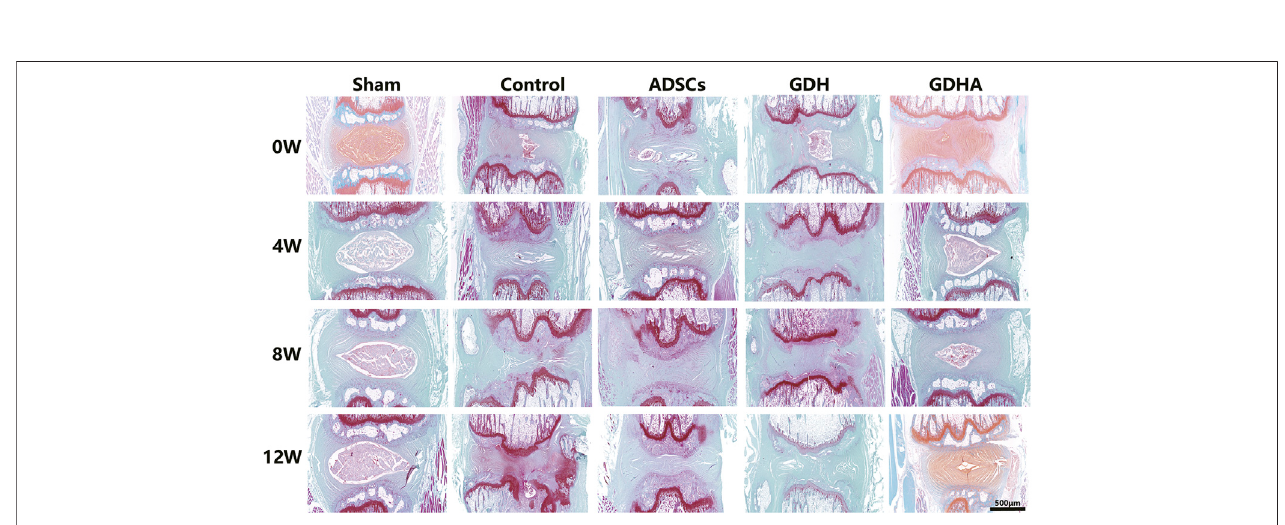
FIGURE 9 | Typical Safranin O – fast green (S – O) staining in the tail discs at 0 (A) , 4 (B) , 8 (C), and 12 (D) weeks after injection. Scale bar (cid:2) 500 μ m.